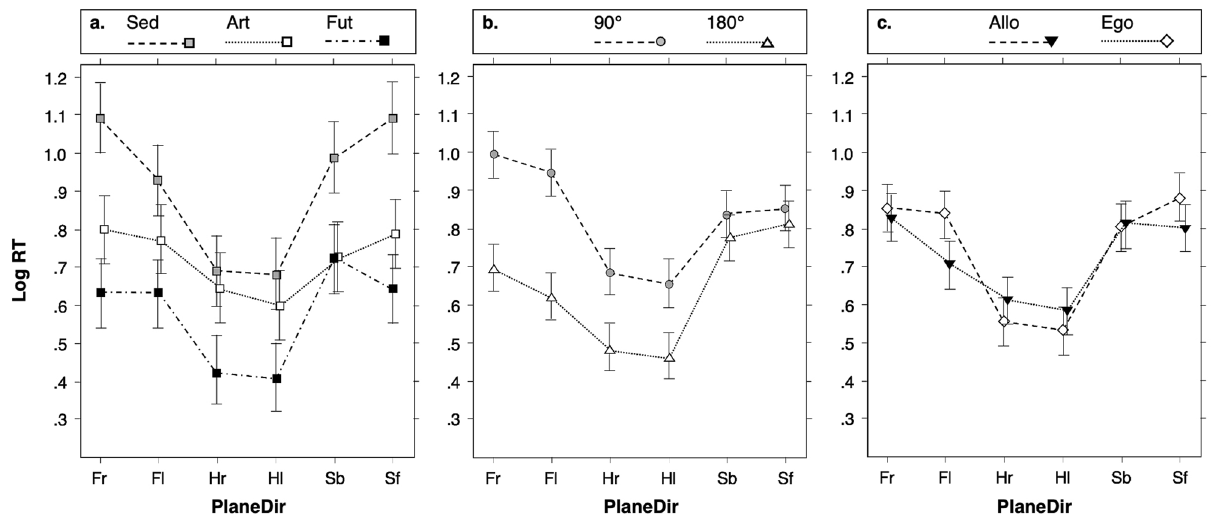
Figure 2. Interaction effects of PA, d° and FR with PlaneDir. The effect-plots 41 a. b. and c. show the adjusted mean log RTs in each PlaneDir condition (plane and direction in which the rotation was imagined), i.e.: rotation in the horizontal plane on the right (Hr) or on the left (Hl), in the frontal plane on the right (Fr) or on the left (Fl), in the sagittal plane on a backward direction (Sb) or forward (Sf). In the effect-plots, the log RTs are shown according to: ( a ) the PA (physical activity) groups (sedentary subjects, Sed; artistic gymnasts, Art and Futsal players, Fut), ( b ) each d° condition (degrees of the imagined rotation: either 90° or 180°) and ( c ) FR conditions (frame of reference to imagine rotation), i.e.: either allocentric (Allo) or egocentric (Ego). In each effect-plot the vertical line segments indicate ± 95% confidence interval. Broken lines connect the log RT values of each PA group (Fig. 2a), of each d° condition (Fig. 2b) and of each FR condition (Fig. 2c) to emphasize the interaction (Fig. 2b; see also: Supplementary Table S11 on line). In the 90° condition, the log RT was faster in the sagittal (S) plane than in the frontal (F) plane with (F–S) = .12 ± .03, z = 4.60 and p = 5e−5. Conversely, in the 180° condi- tion, the log RT was slower in the sagittal plane than in the frontal plane with (F–S) = − .14 ± .03, z = − 5.60 and p = 2.55e−7. Whatever the d° condition, no statistically significant difference was found between the two possible direc- tions in each plane, as shown by the Fig. 2b (three computed differences in each of the two d° conditions with p ≥ .352; see: Supplementary Table S11 on line). In addition, no statistically significant difference between the log RTs in the two d° conditions was found in the sagittal plane ( p = .237; see: Fig. 2b and Supplementary Table S12 on line) while the mean log RTs in the frontal and horizontal planes were faster in the 180° condition than in the 90° condition (Fig. 2b; see: Supple- mentary Table S12 on line); the respective differences were: (90°–180°) = .31 ± .03 with z = 12.18 and p < 1e−15, and (90°–180°) = .19 ± .03 with z = 7.71 and p = 7.44e−14.